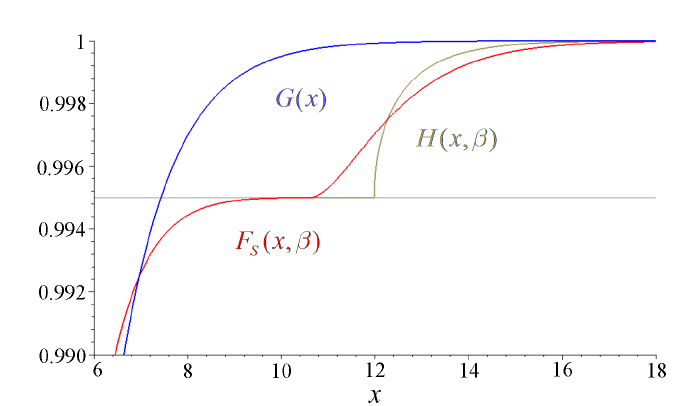
Figure 4: Plots of the cdf’s F S ( x , β ) , G ( x ) and H ( x , β ) for β = 0.005 in Example 1.